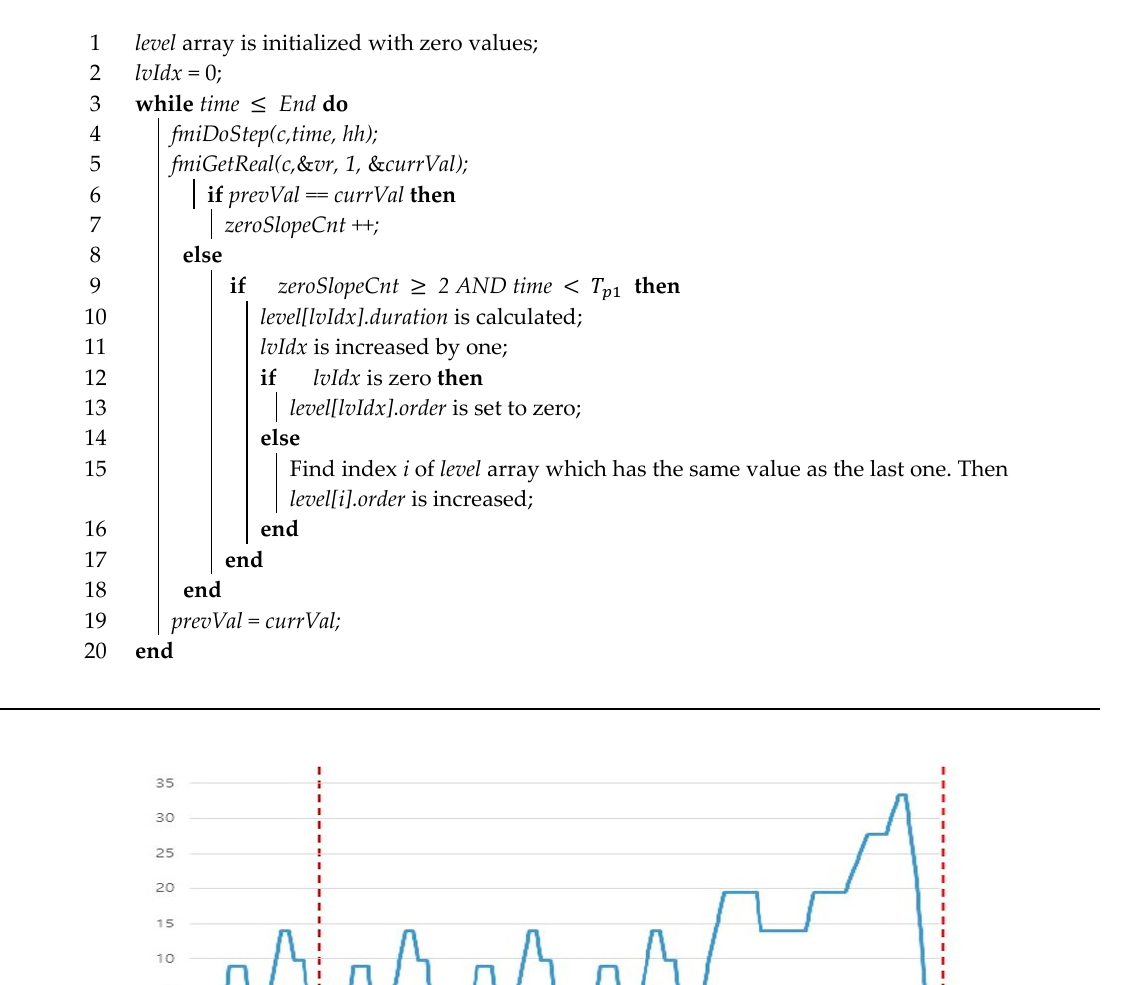
Figure 6. Sequence diagram of the redundancy reduction algorithm. Algorithm 1: adaptive step size algorithm (saving level patterns)